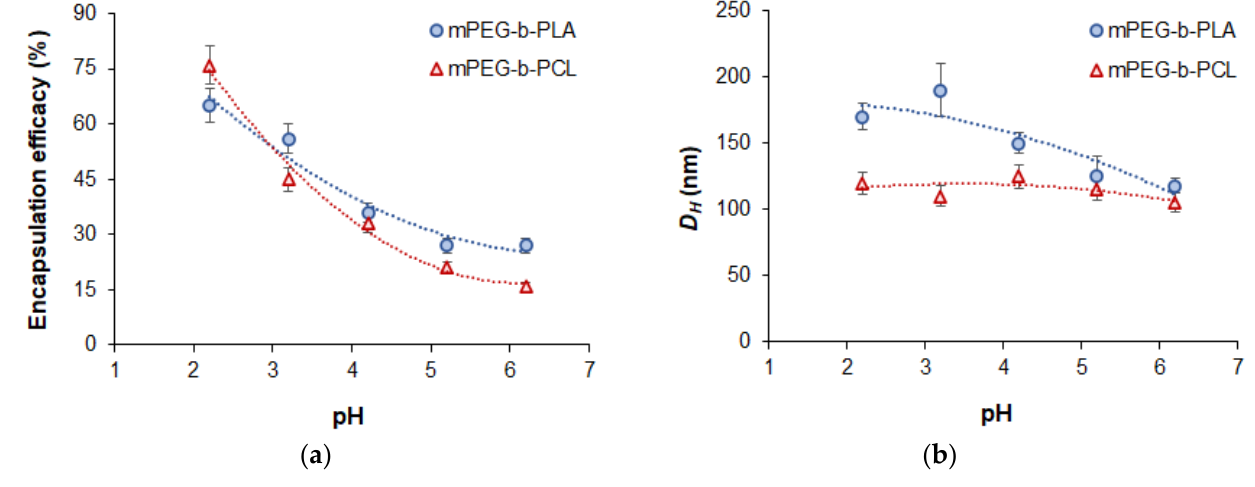
Figure 7. Effect of pH on the encapsulation efficacy ( a ) and hydrodynamic diameter ( b ) of the dioxadet delivery systems based on mPEG- b -PLA ( Mw = 36,400) and mPEG- b -PCL ( Mw = 29,200). The dioxadet/polymer ratio was 50 µg/mg of polymer.